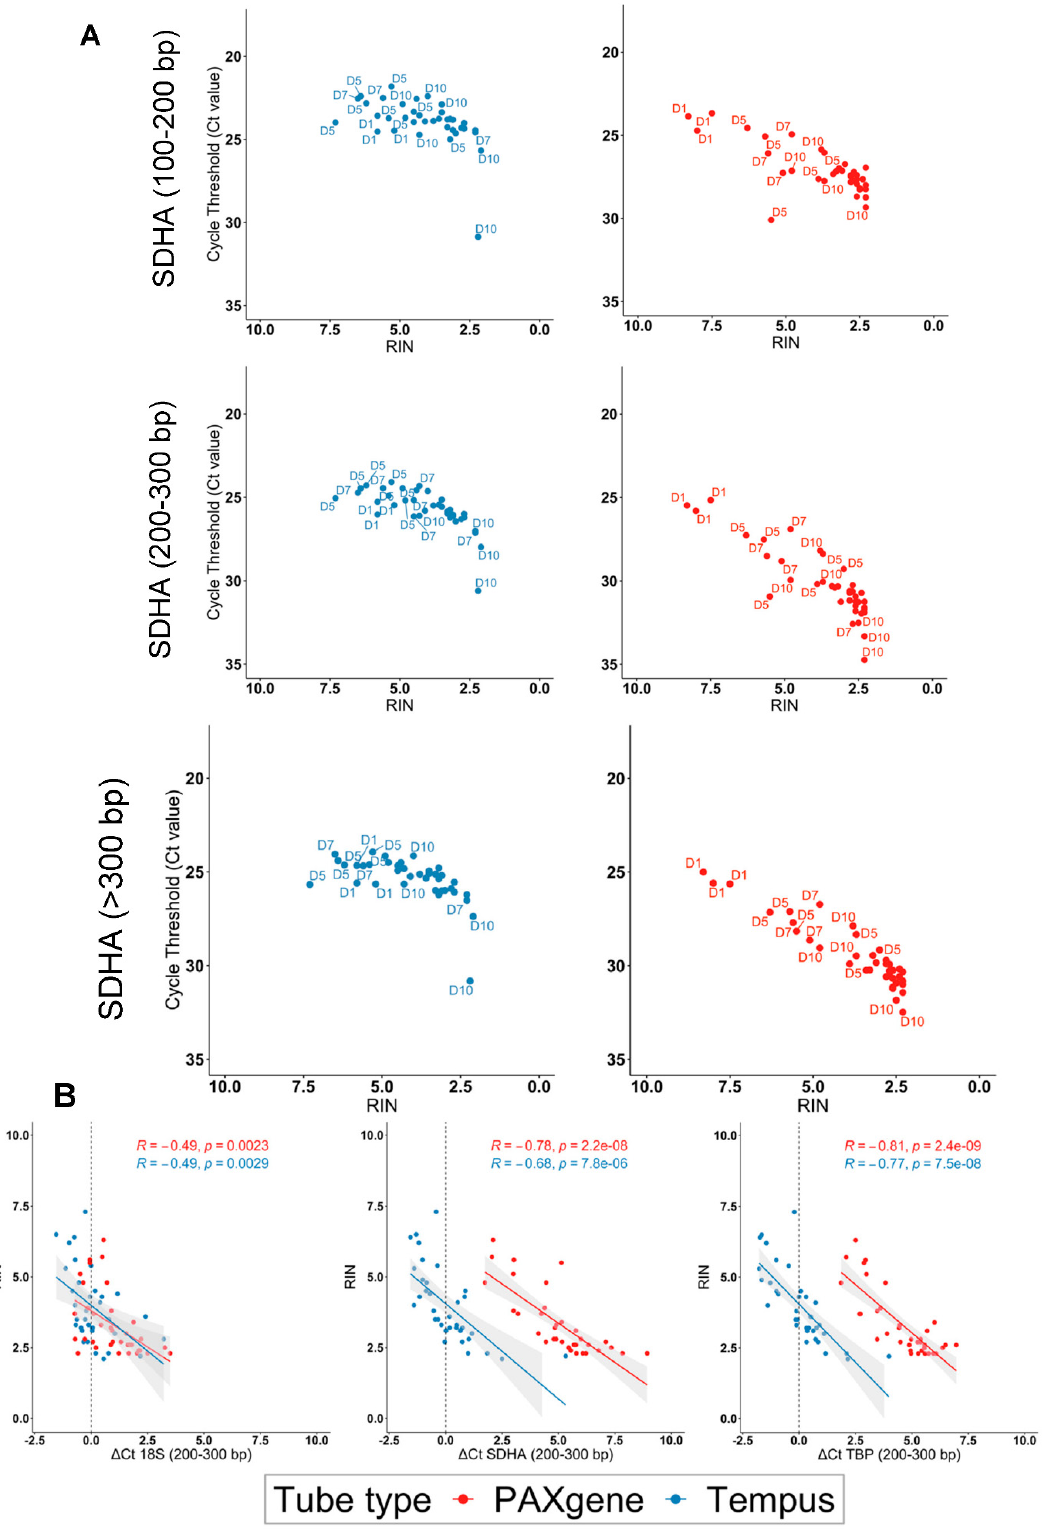
Figure 3. Cycle thresholds (Ct) in dependence on amplicon length and RNA integrity (RIN). ( A ) Scatter plots show the Ct values in dependence on amplicon length and RNA integrity (RIN) for different lengths of SDHA amplicons differences for each tube type. ( B ) Spearman correlation of the ∆ Ct values with RIN value (RNA quality) for medium-length amplicons (200–300 bp) of 18S ( left ), SDHA ( middle ), and TBP ( right ). Blue, Tempus ™ Blood RNA tubes; red, PAXgene ® Blood RNA tubes. To test if the presence of PCR inhibitors, which are often co-extracted from whole blood (e.g., haemoglobin, lactoferrin, anticoagulants, etc.) [23,24], could have contributed to these results, RT-qPCR was performed on a log 2 serial dilution of undiluted extraction eluent. We considered that a trendline gradient of Ct values relative to the dilution greater than − 3.3 (i.e., E’ < 100%) was indicative of the presence of PCR inhibitors [23]. There was no apparent effect of inhibitors in both PAXgene ® or Tempus ™ tubes when the samples were diluted below 60 ng/uL (Figure S3). These data demonstrated that our findings were unlikely to be a consequence of inhibitors present in the RT-qPCR reaction. In summary, our data showed that Tempus ™ tubes maintained a higher RNA quan- tity and integrity comparatively to PAXgene ® tubes when RNA is stored in suboptimal tropical conditions. Furthermore, Tempus ™ tubes maintained stability of mRNA in condi- tions where RNA samples were heavily degraded as indicated by RIN. Taken together, this study establishes that the Tempus™ blood RNA collection system resulted in a better quality of RNA and enhanced stability of mRNA when whole-blood samples are stored under suboptimal tropical conditions.